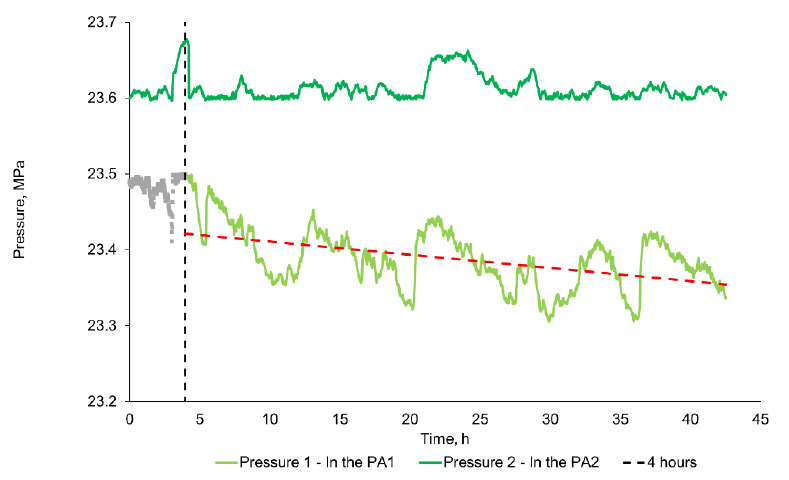
Figure 8. Cross-plot for the volumetric expansion coefficient and chlorite/TOC mass ratio in the swelling experiments with the hydrocarbon-based fluid .